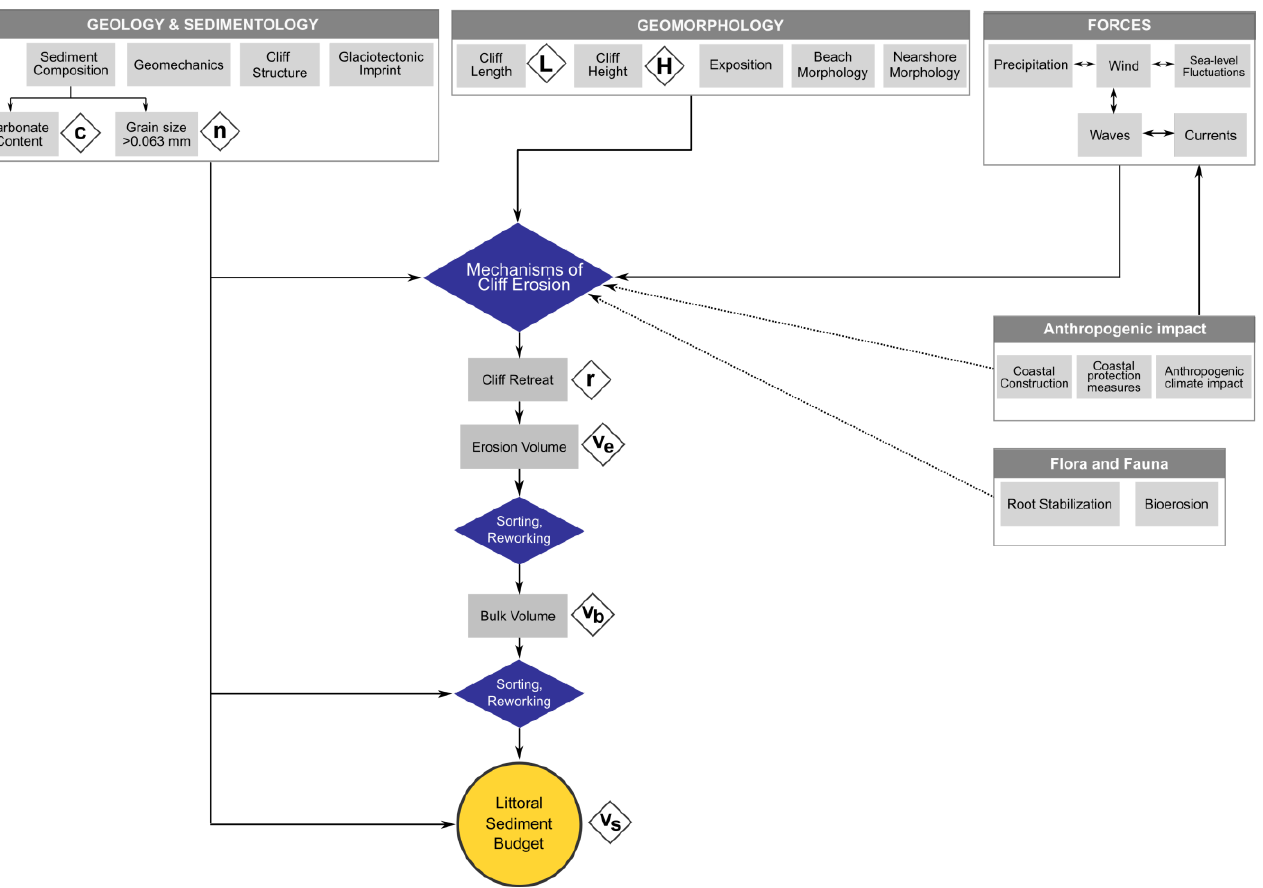
Figure 6. Factors and variables generating and/or affecting the littoral sediment budget from cliff erosion in a wave-dominated environment.